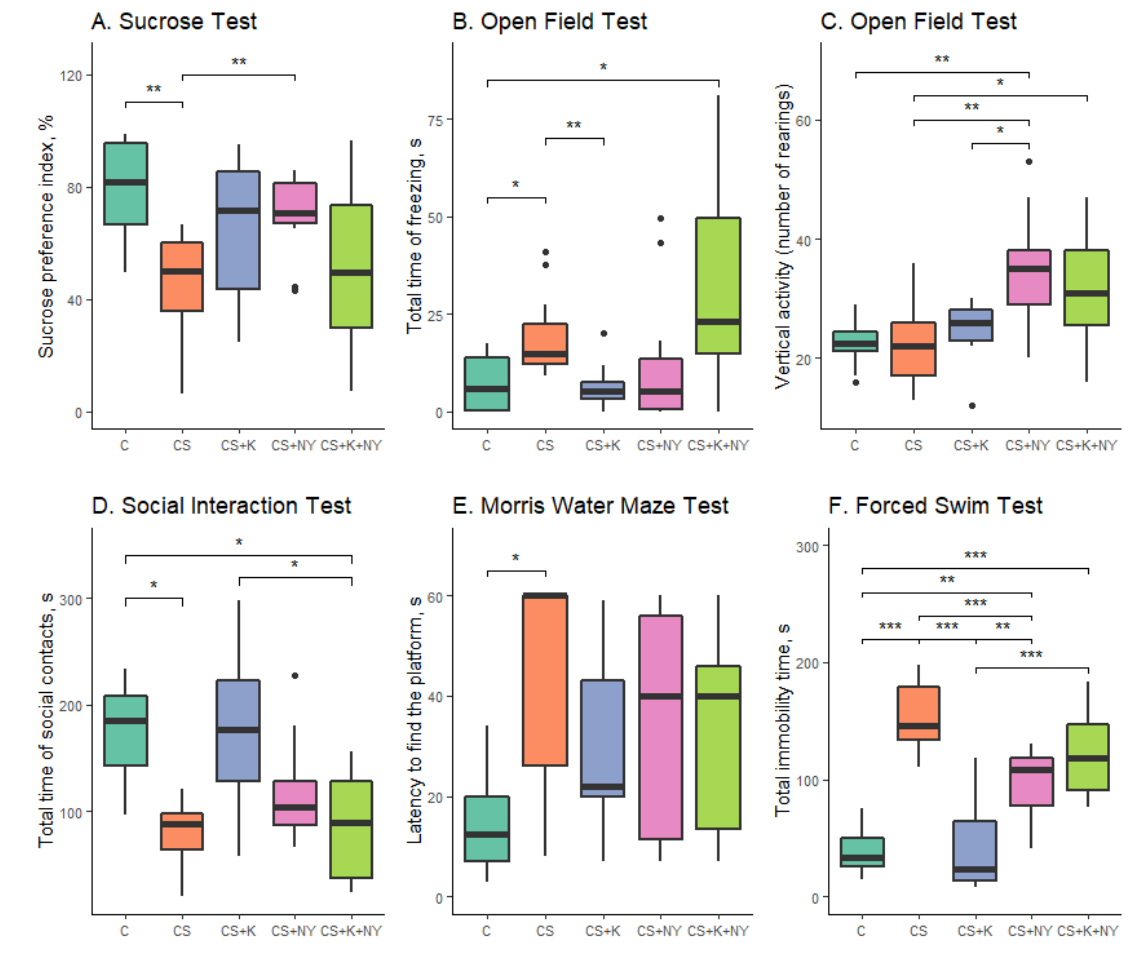
Figure 3. The results of the experiment involving chronic stress. C—control rats; CS—rats exposed to chronic stress; CS + K—rats exposed to chronic stress and administrated with clomipramine; CS + NY—rats exposed to chronic stress and administrated with neuropeptide Y; CS + K + NY—rats exposed to chronic stress and administrated with clomipramine and neuropeptide Y; *— p < 0.05; **— p < 0.01; ***— p < 0.001.